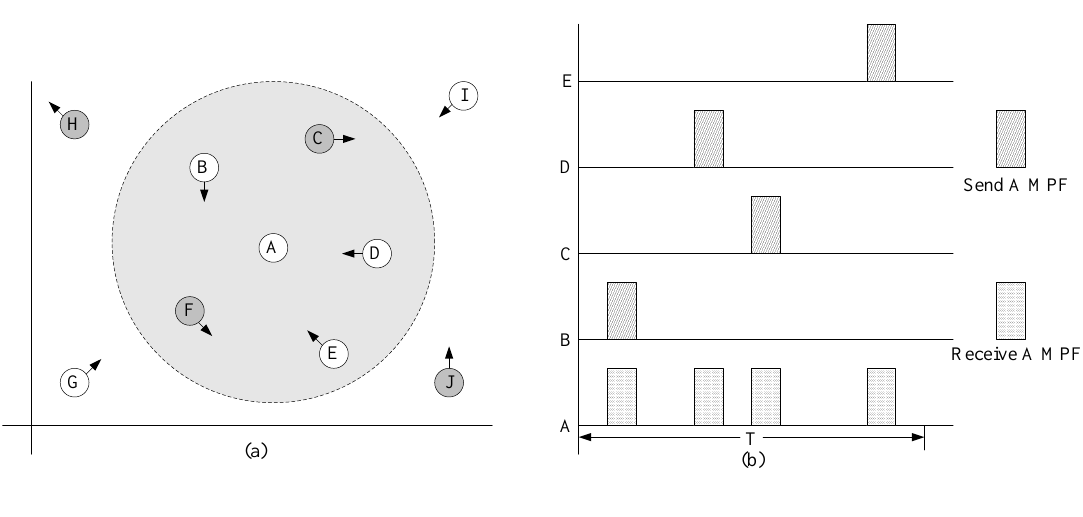
Figure 1. Neighbor